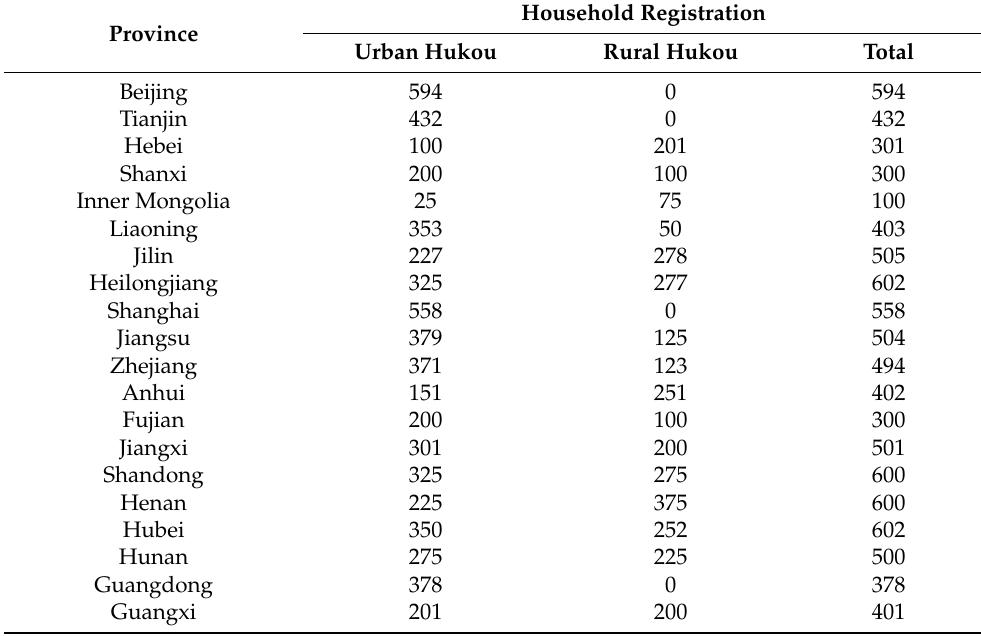
Table A1. Distribution of CGSS data in different provinces of